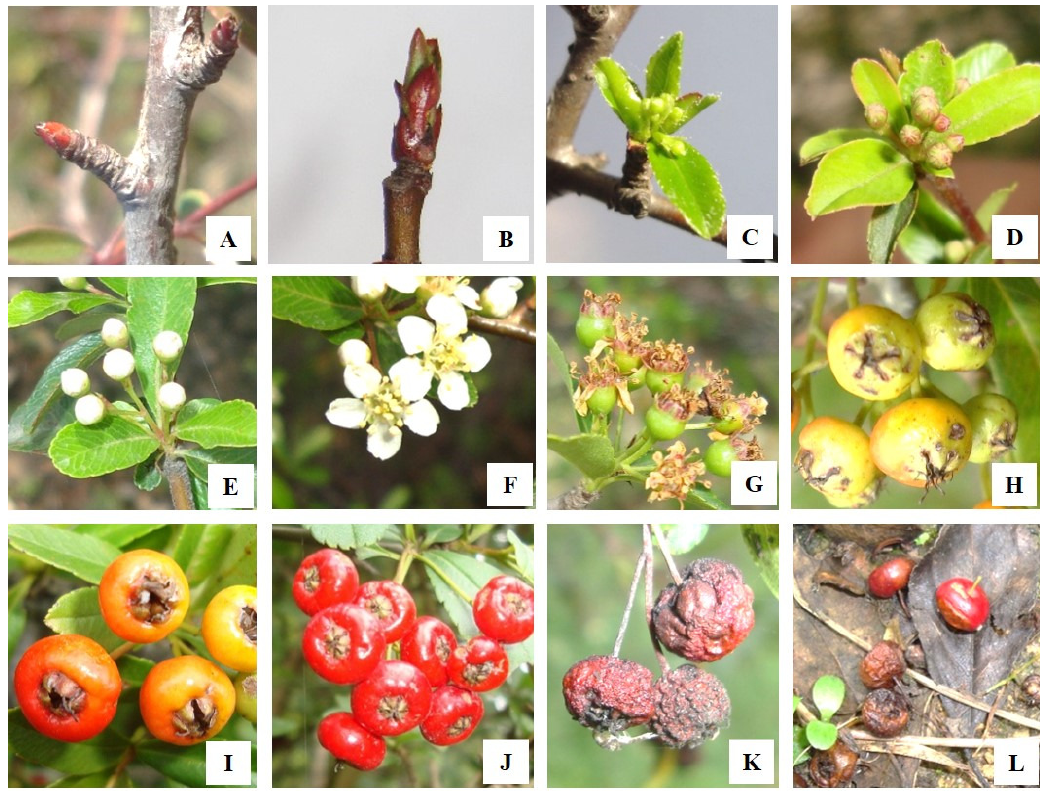
Figure 3. Flowering and fruiting phenological stages of P. crenulata : (A) mixed bud, (B) bud burst, (C) emerging flower buds, (D) pinkish green developing flower buds, (E) creamy white flower buds, (F) flowers, (G) fruits with dried petals and stamens attached, (H) pale green fruits, (I) orange-red fruits, (J) deep red (mature) fruits, (K) dried fruits after maturity, (L) dried and mature fruits dropped on ground Fruit setting and